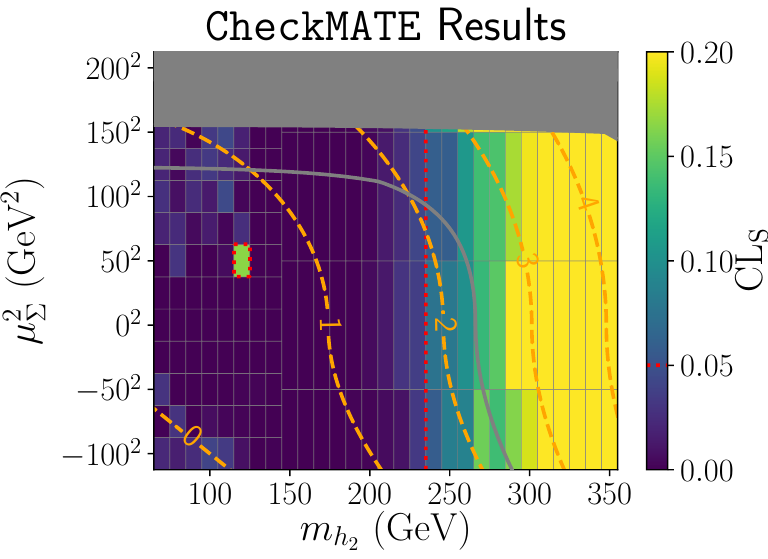
Figure 10. CheckMATE CL S exclusion values evaluated on a grid of masses and quadratic terms with v (cid:6) = 1 GeV and b 4 = 1. Points with CL S 0 : 05 are excluded at 95% con(cid:12)dence. The (cid:20) CL S = 0 : 05 contour is indicated by a dashed red line. The dotted orange lines are contours of constant triplet-Higgs coupling. The solid grey region is the parameter-space where the scalar couplings become non-perturbative at energies (cid:3) < 1 TeV, and the solid grey line shows where this contour would be if the cuto(cid:11) energy is increased to (cid:3) = 10 6 GeV. The perturbativity contour does not use b 4 = 1, and instead selects b 4 as described for (cid:12)gure